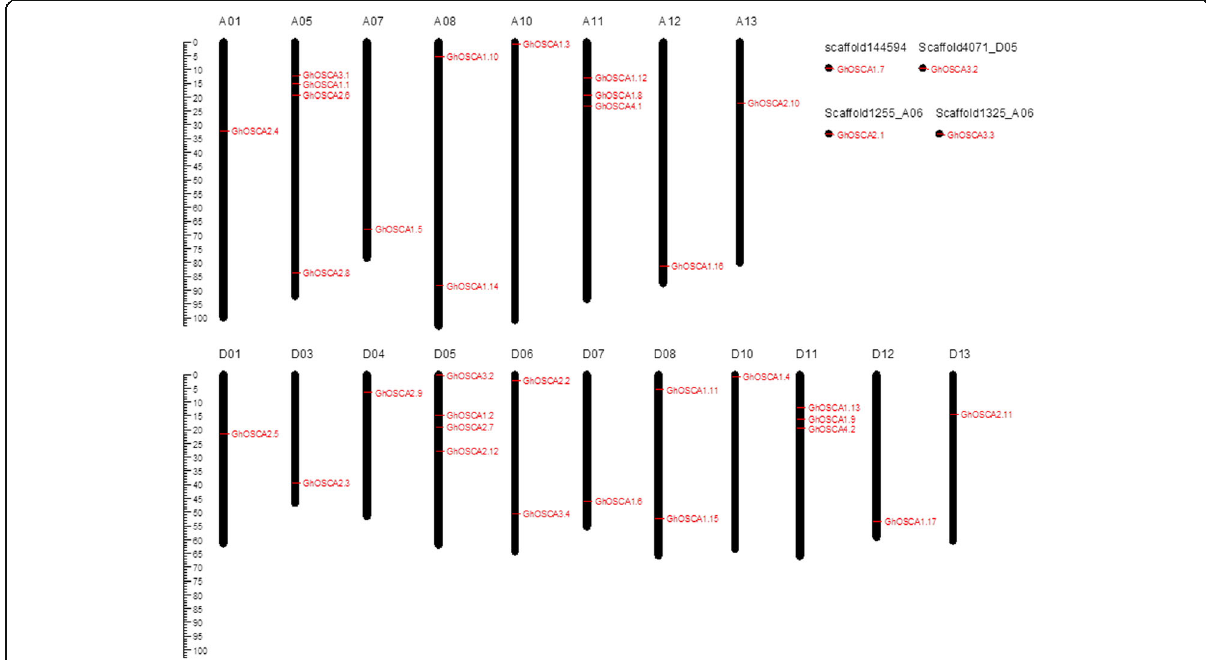
Fig. 5 The distribution of OSCA genes on